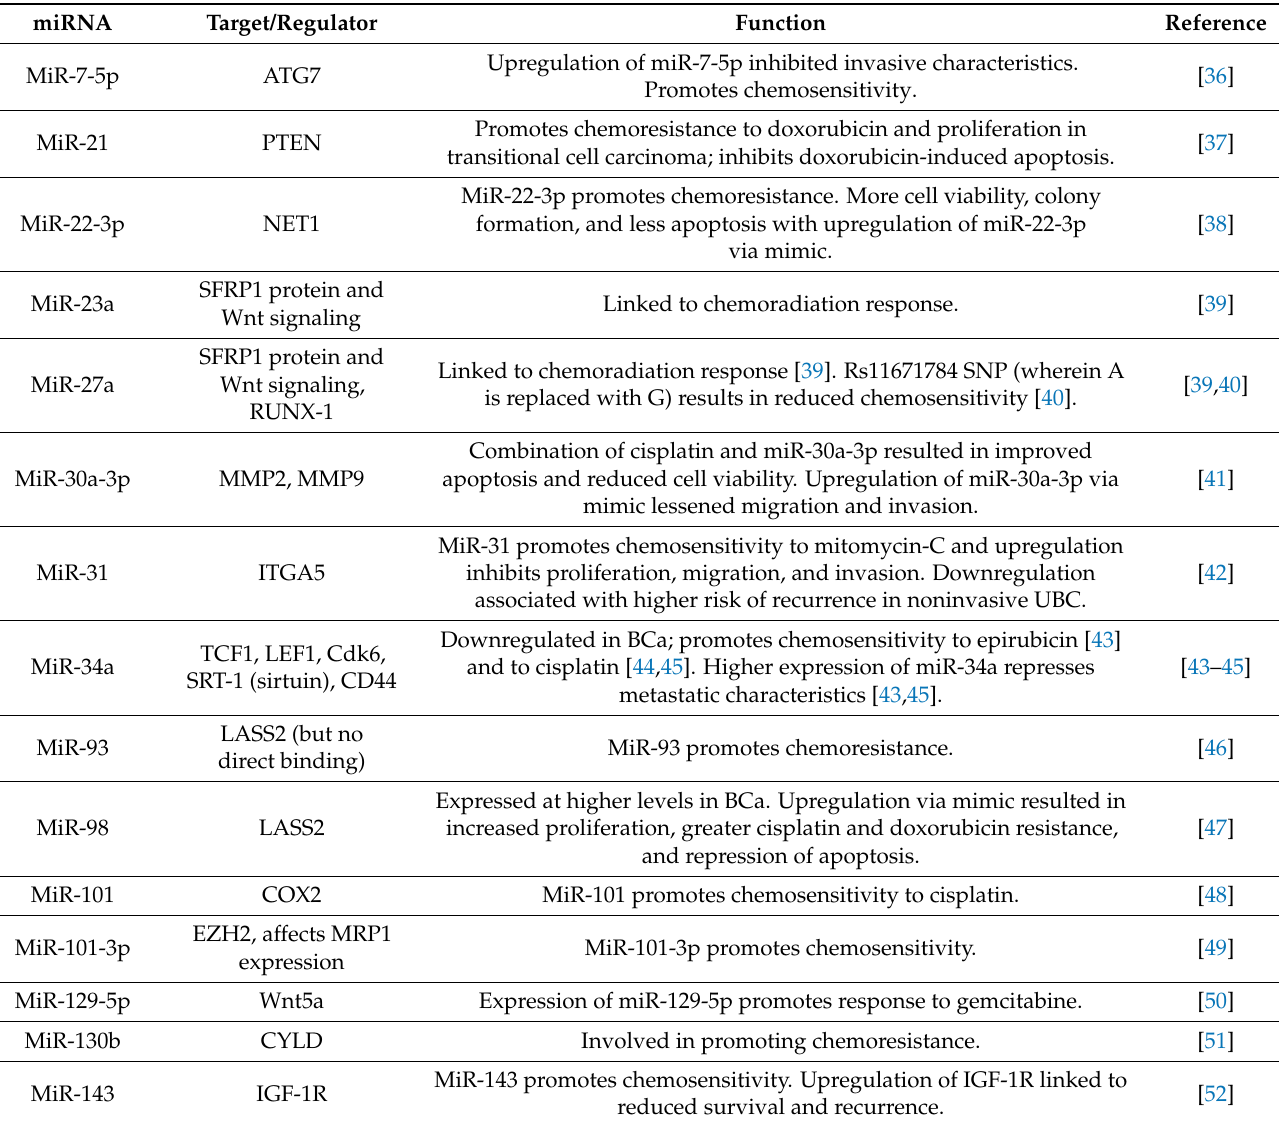
Table 2. miRNAs and associated targets/regulators involved in BCa